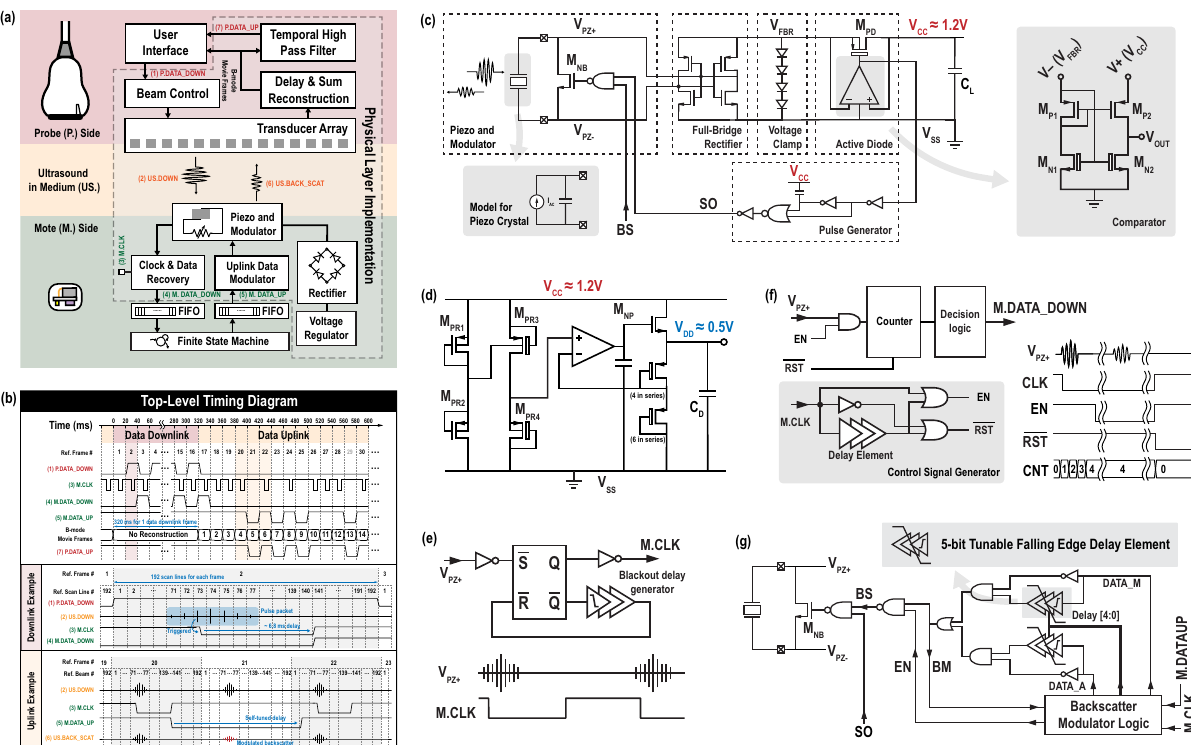
Fig. 3 Circuit implementation of the physical layer. a Block diagram for the imaging system and the mote with the physical layer implementation highlighted; b top-level timing diagram of the key signals, with the pulse packet seen from the mote, assumed between 71st and 77th scanline of each frame; c the active recti fi er; d the voltage regulator; e the clock recovery circuit; f the data recovery circuit; and g the uplink backscatter